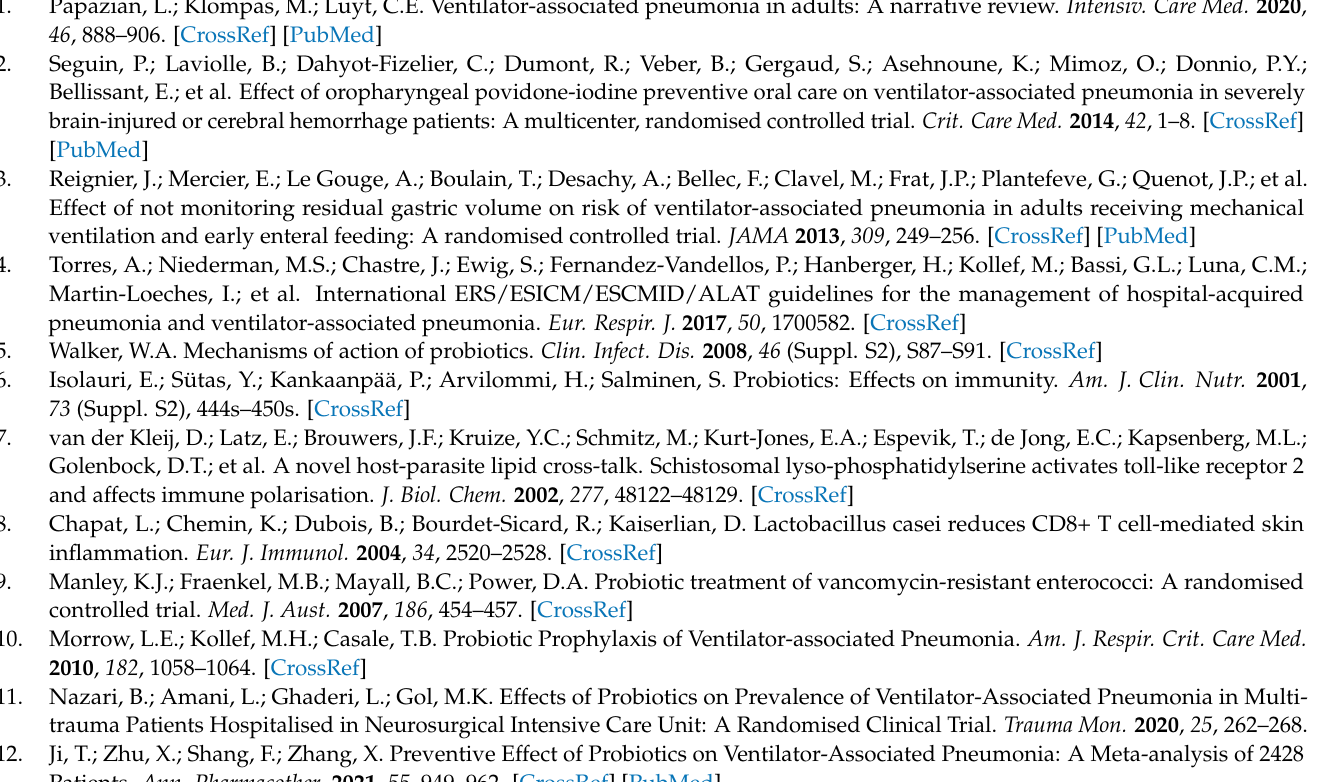
strategies for online databases; Figure S1: Funnel plot for incidence of VAP; Figure S2: Effect of probiotics on the duration of mechanical ventilation: Figure S3: Funnel plot for the duration of me- chanical ventilation; Figure S4: Effect of probiotics on the length of ICU stay: Figure S5: Funnel plot for the length of ICU stay; Figure S6: Effect of probiotics on the length of hospital stay; Figure S7: Doi plot for the length of hospital stay: Figure S8: Effect of probiotics on: (a) ICU mortality; (b) Hospital mortality; (c) 28/30-day mortality; Figure S9: Doi plot for ICU mortality; Figure S10: Doi plot for hospital mortality; Figure S11: Doi plot for 28/30-day mortality; Figure S12: Effect of probi- otics on the duration of antibiotic use; Figure S13: Doi plot for the duration of antibiotic use; Figure S14: Effect of probiotics on the incidence of diarrhoea; Figure S15: Doi plot for the incidence of diarrhoea; Figure S16. Sensitivity analysis by excluding studies at some concerns of bias in the randomization